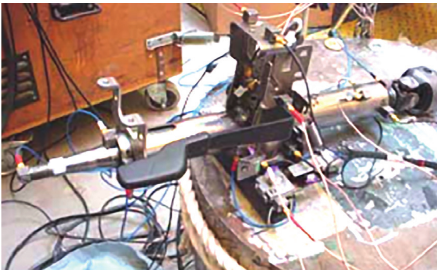
Figure 13: Substructure test bed of the steering system [104].